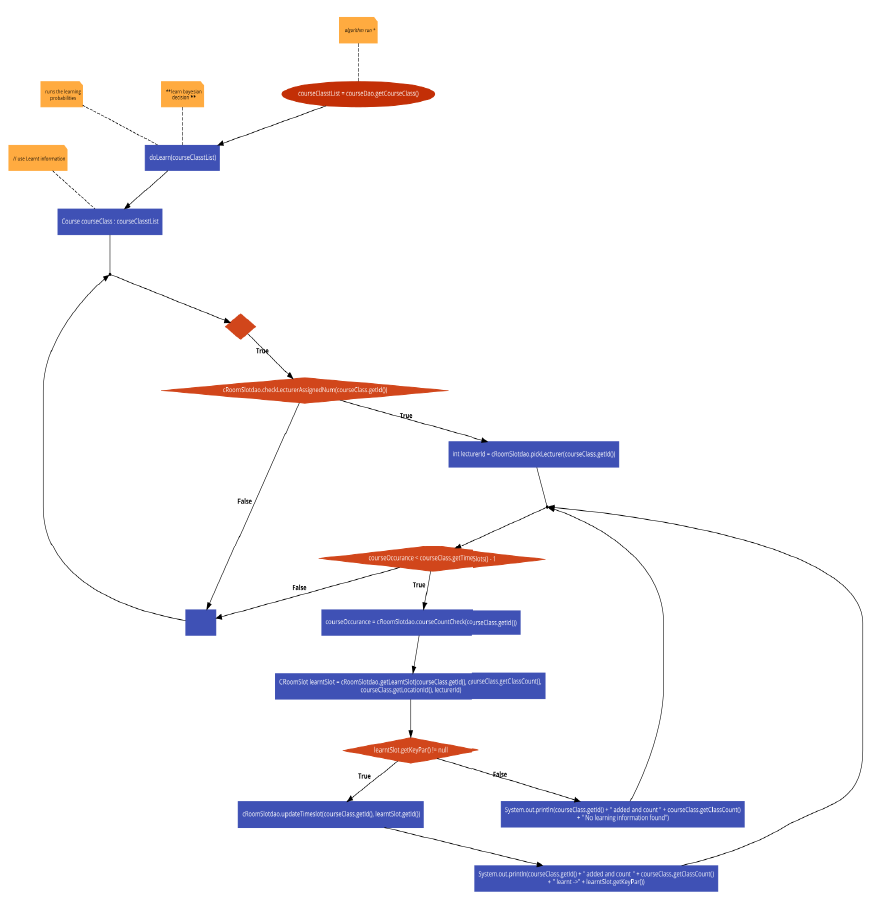
Fig. 3. Algorithm with optimization using learnt